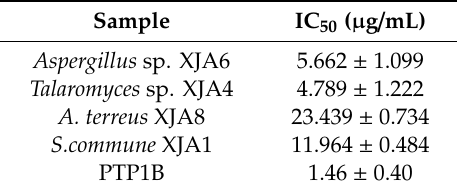
Table 4. Antidiabetic activities of ethyl acetate crude extracts of selected endophytic fungi.